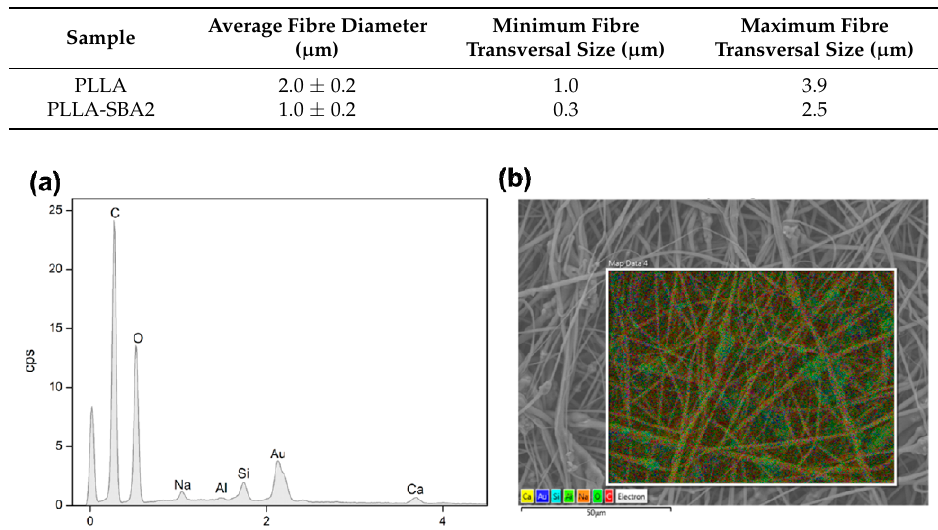
Figure 2. SEM micrographs of ( a ) neat polylactic acid (PLLA) fibres and ( b ) PLLA-SBA2 fibres (scale bar = 25 µm). Neat PLLA fibres ( c ) and composite fibres ( d ) at high magnification, evidencing their highly porous surface. Scale bar: 2 µm. Table 1. Average diameters, minimum and maximum values measured for the transversal size of neat polymeric and composite fibres.